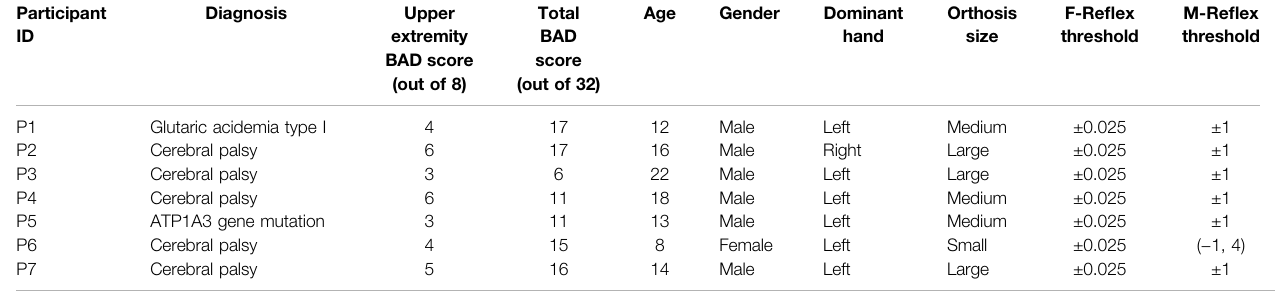
TABLE 1 | Study participant details.